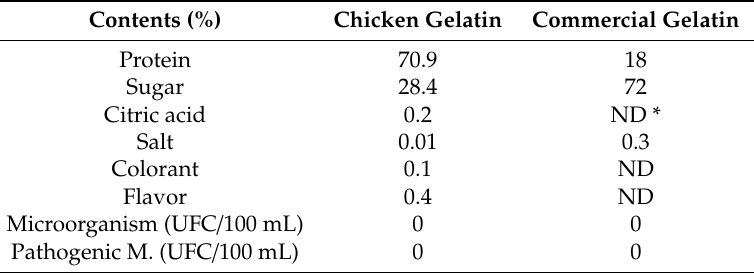
Table 1. Composition of gelatins produced in this